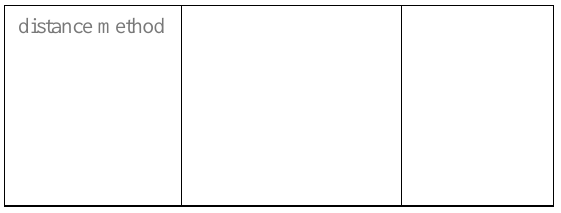
Table 2. Supervised classification accuracy